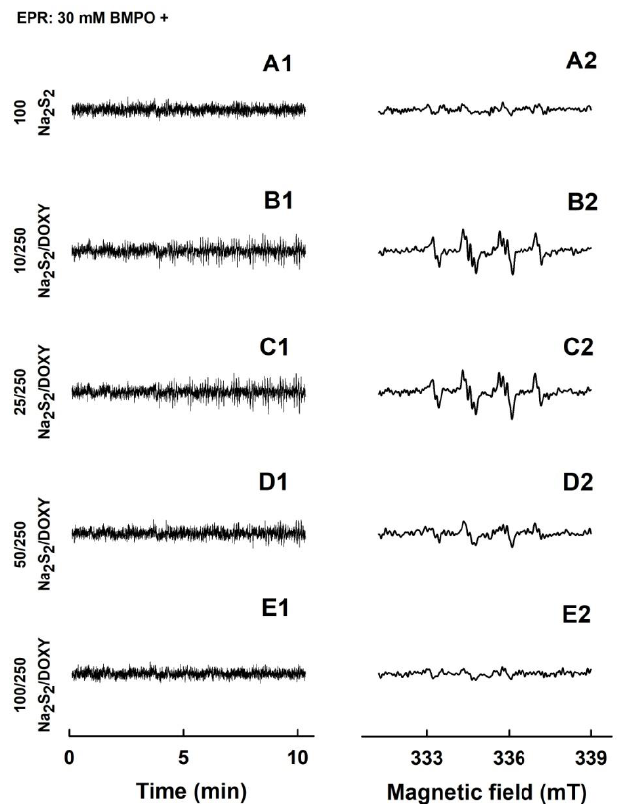
Figure 6. EPR spectra of the • BMPO-adducts for Na 2 S 2 and Na 2 S 2 /DOXY. Sets of individual EPR